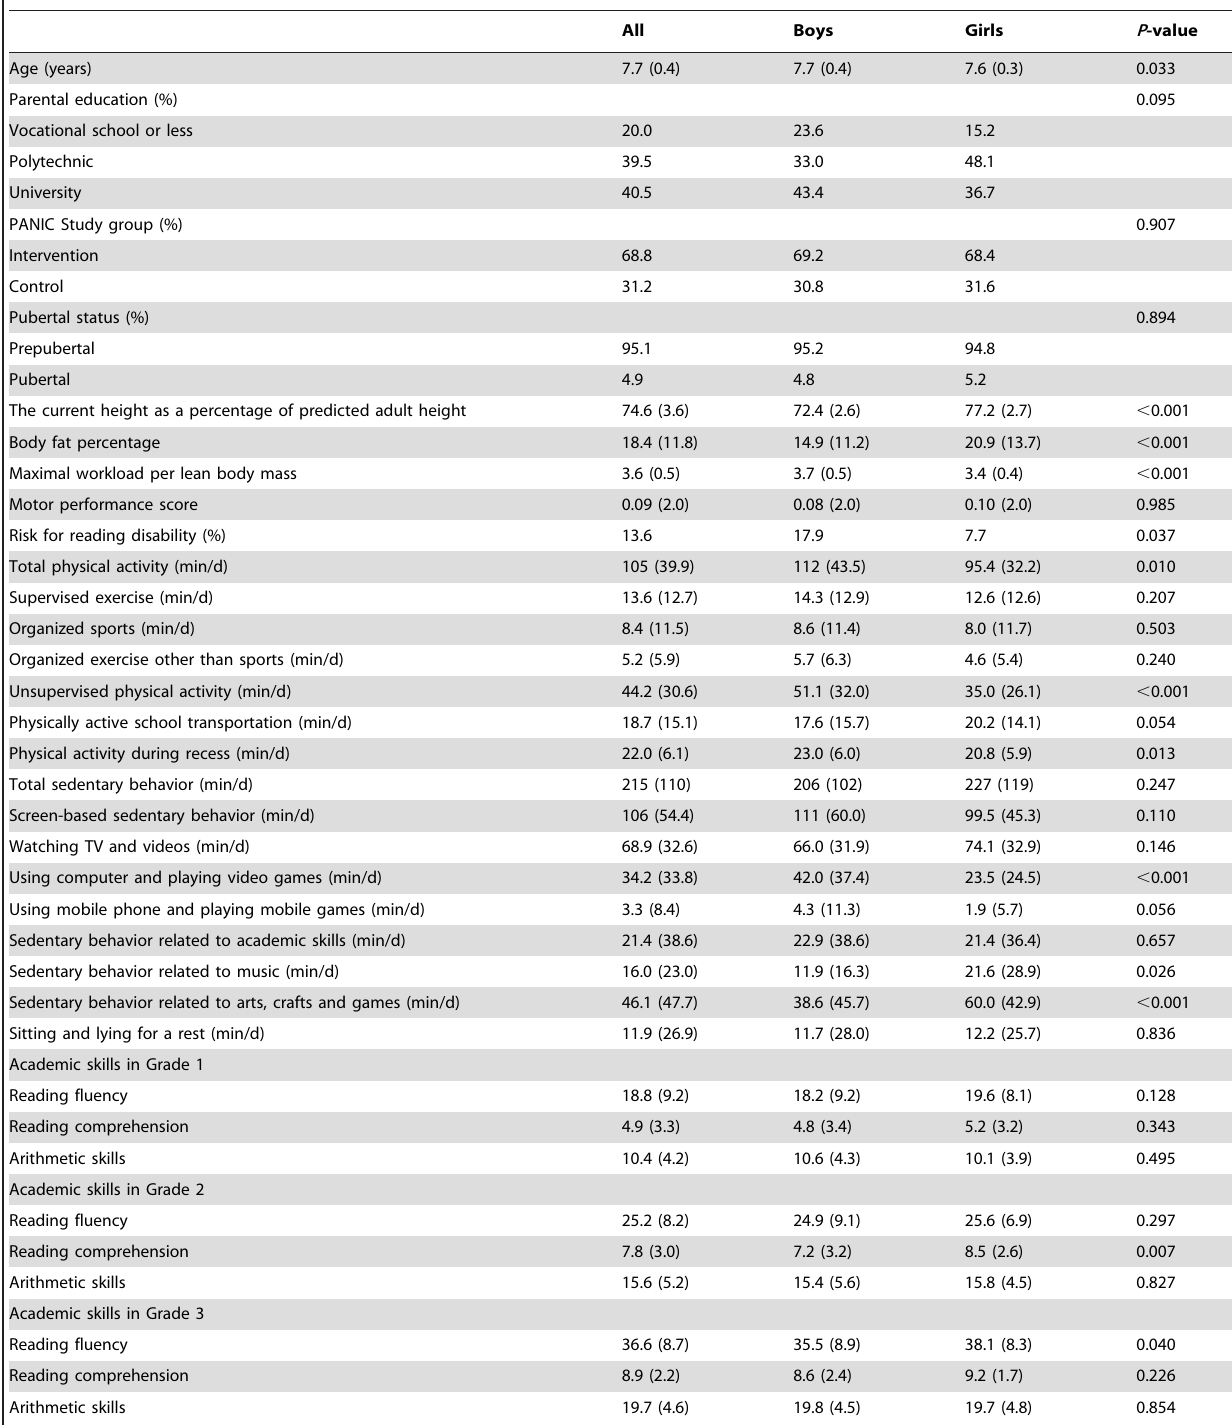
Table 1. Basic characteristics of 186 children (107 boys and 79 girls).